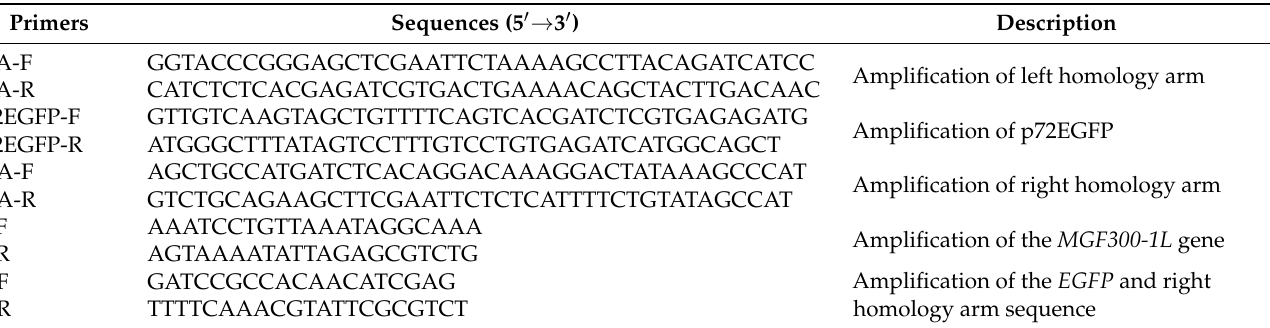
Table 1. Primers were used in this